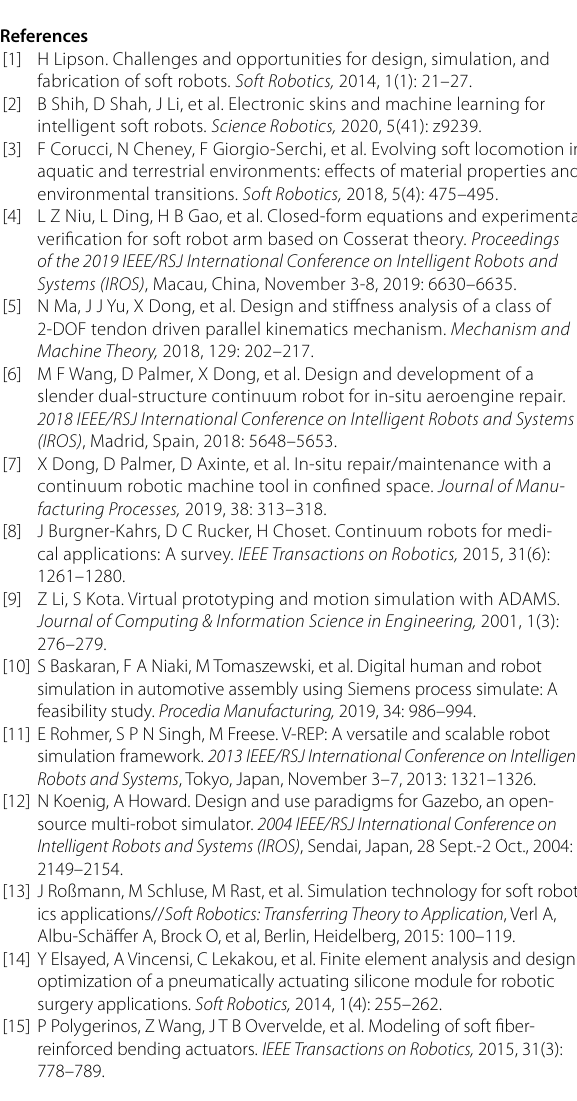
Figure 14 Experimental results of two-cable-driven arm and comparison with